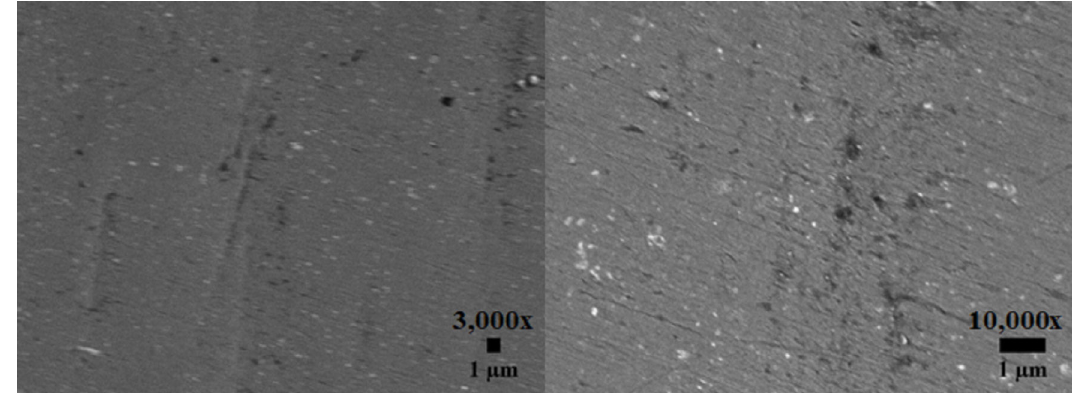
Figure 1. Images of unoxidized grade 2 titanium surface.